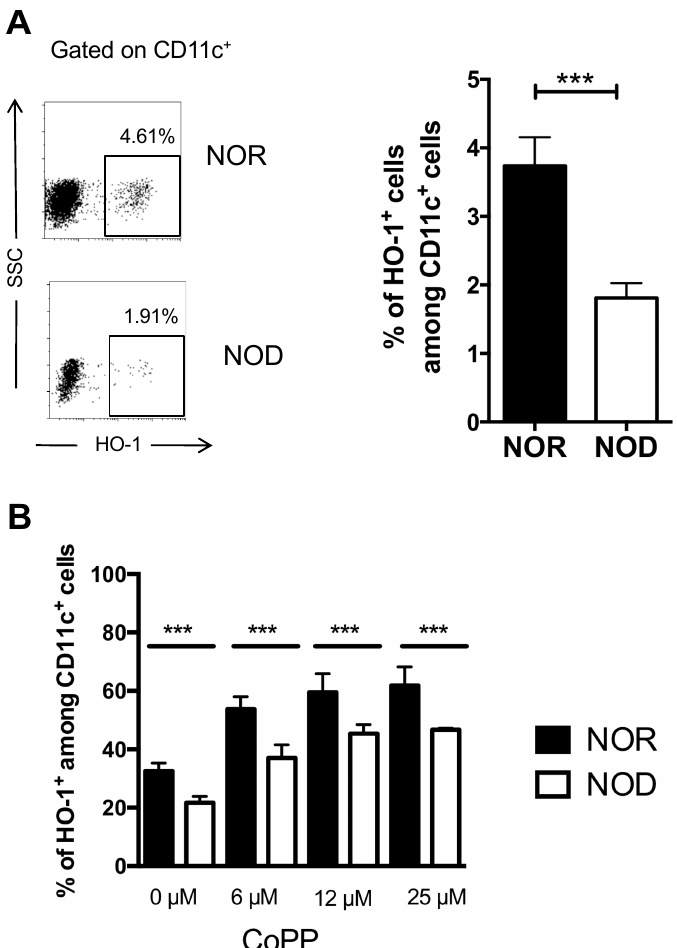
Figure 1. Heme oxygenase-1 expression deficiency in NOD DCs. ( A ) HO-1 expression in splenic CD11c + cells was evaluated in one-month-old female NOD and NOR mice by flow cytometry. Representative dot plots (left panel) and mean frequencies of splenic HO-1 + CD11c + cells ± s.e.m. ( n ≥ 7 mice/group) (right panel) are reported. ( B ) Flow cytometry analysis showing HO-1 expression in CD11c + of bone marrow-derived DCs (BMDC) from NOD and NOR mice treated or not with CoPP for 24 h. Mean frequencies of splenic HO-1 + CD11c + cells ± s.e.m. ( n ≥ 8 mice/group) from 3 independent experiments are reported. An unpaired t -test ( A ) and a one-way ANOVA followed by Tukey’s post-hoc test ( B ) were performed. ***, p < 0.001.